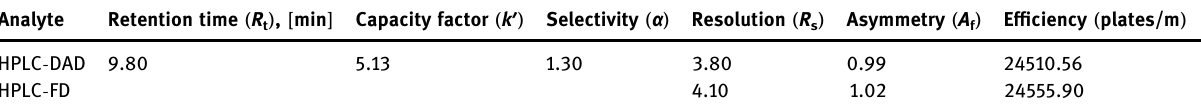
Table 1: System suitability parameters for RM peak Analyte